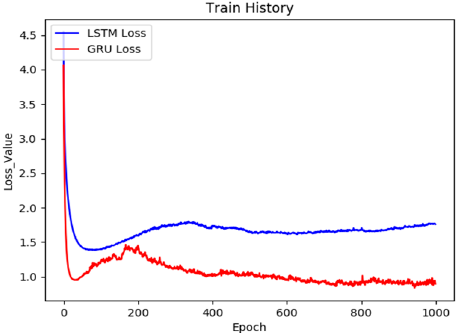
Figure 12. The learning curve of the image caption model.